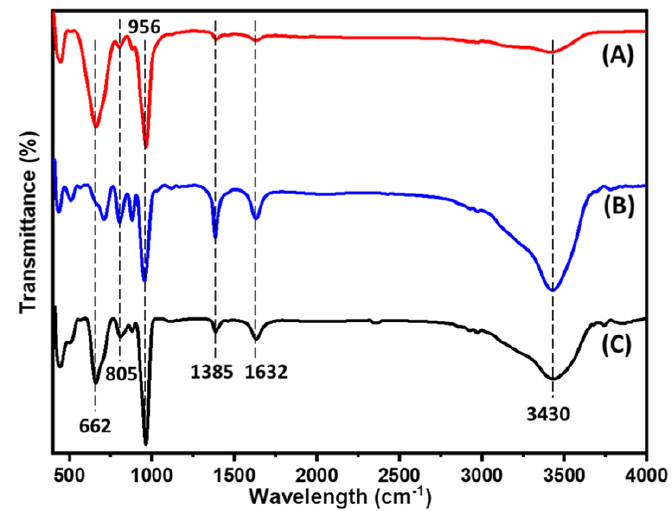
Figure 4. FT-IR spectra of all catalysts prepared using char supports activated by different char act-vation methods: ( A ) NiMo/AC 0 , ( B ) NiMo/AC X and ( C ) NiMo/AC T .